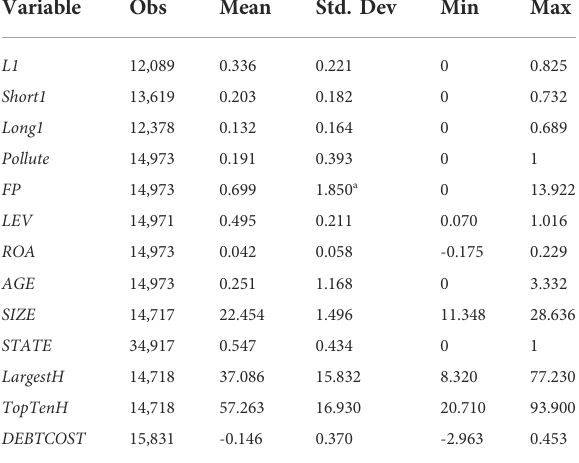
TABLE 2 Descriptive statistics.